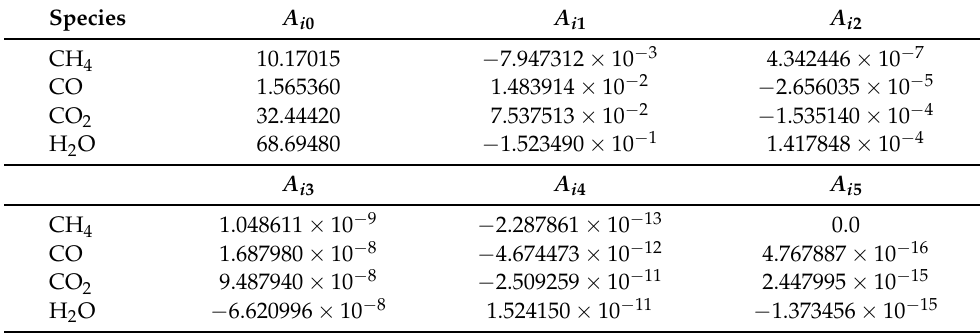
Table 1. Fitting coefficients for the calculation of the Planck mean absorption coefficient.